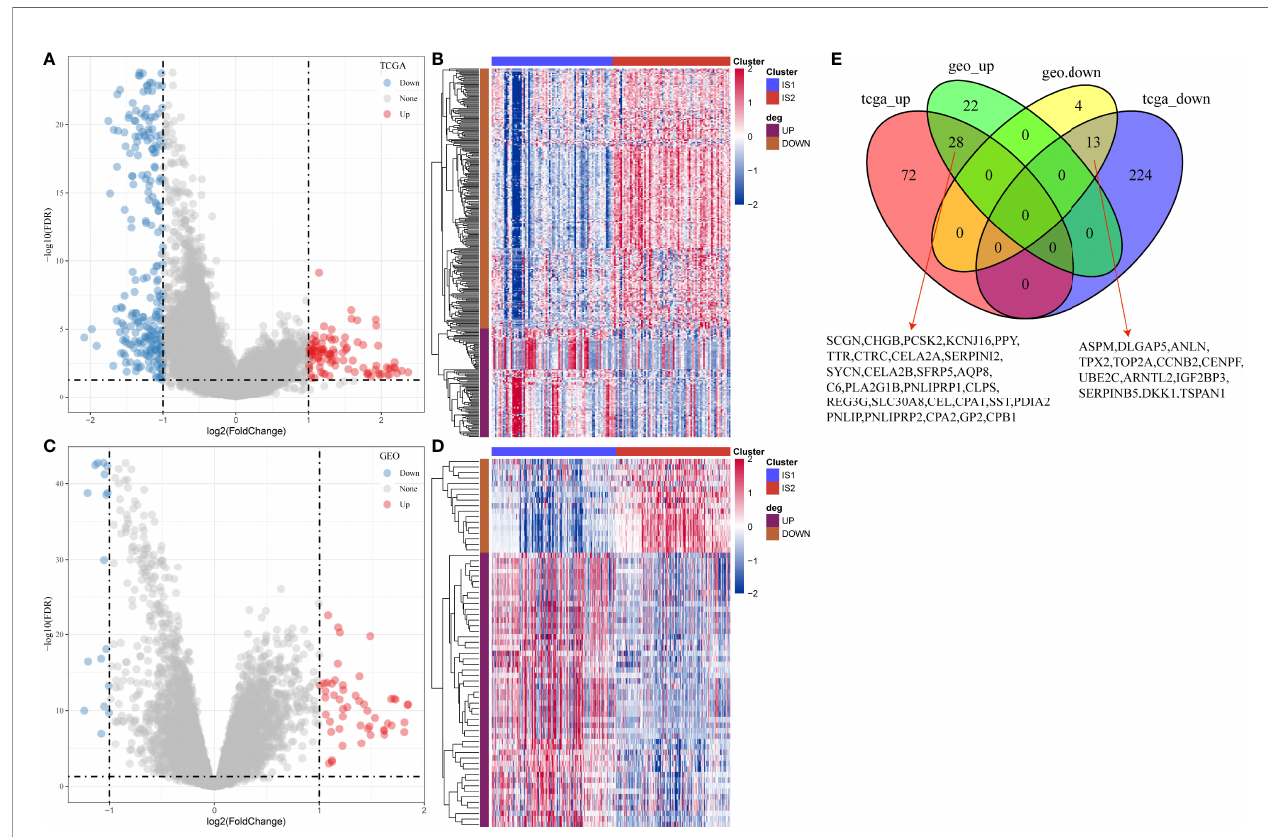
FIGURE 5 | Differential analysis between IS1 and IS2. (A) Volcano plot of DEGs in TCGA-PAAD cohort. (B) Unsupervised consensus clustering for TCGA-PAAD samples based on DEGs. (C) Volcano plot of DEGs in GEO cohort. (D) Unsupervised consensus clustering for GEO samples based on DEGs. (E) Venn plot of upregulated and downregulated genes in TCGA-PAAD and GEO cohorts.